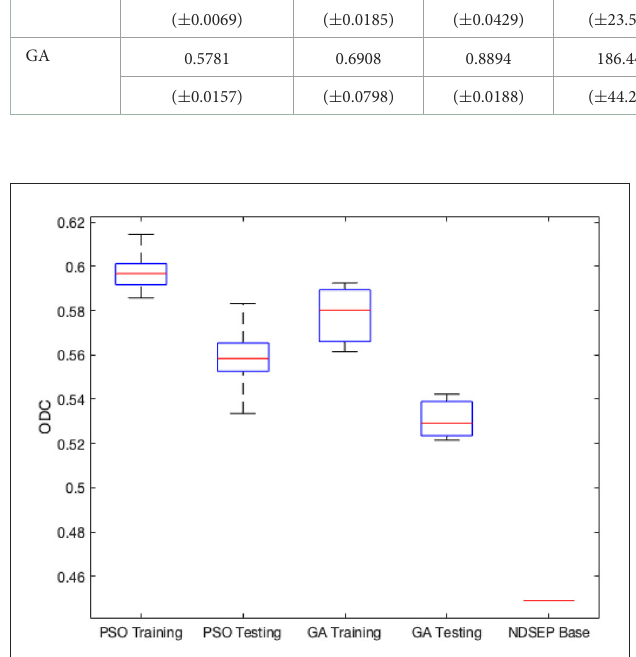
FIGURE4 Minimum, maximum, quartiles, and average of the ODC over all k = 3 experimental groups for